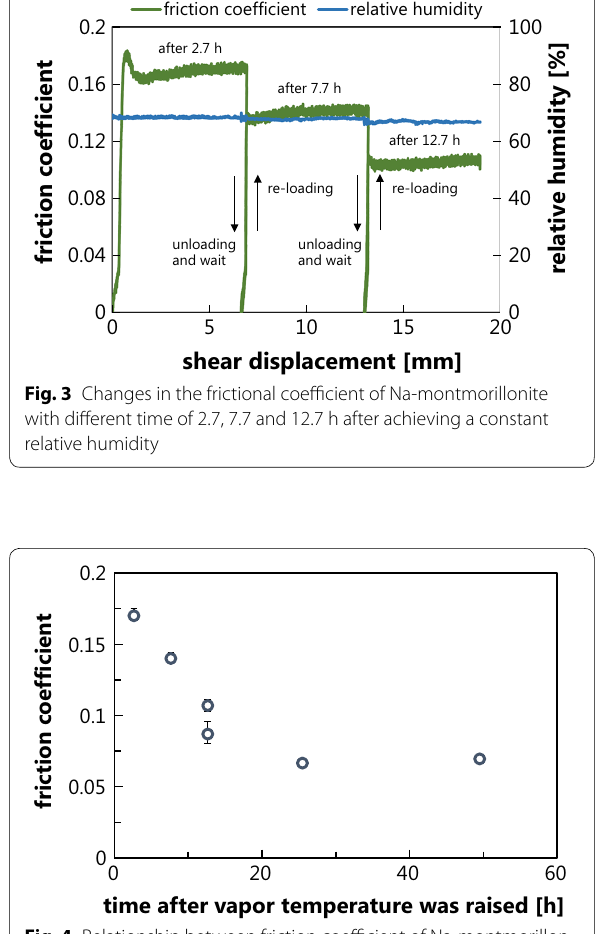
Fig. 4 Relationship between friction coefficient of Na-montmorillon- ite and time after temperature of vapor was raised to a target value at the relative humidity of 70%